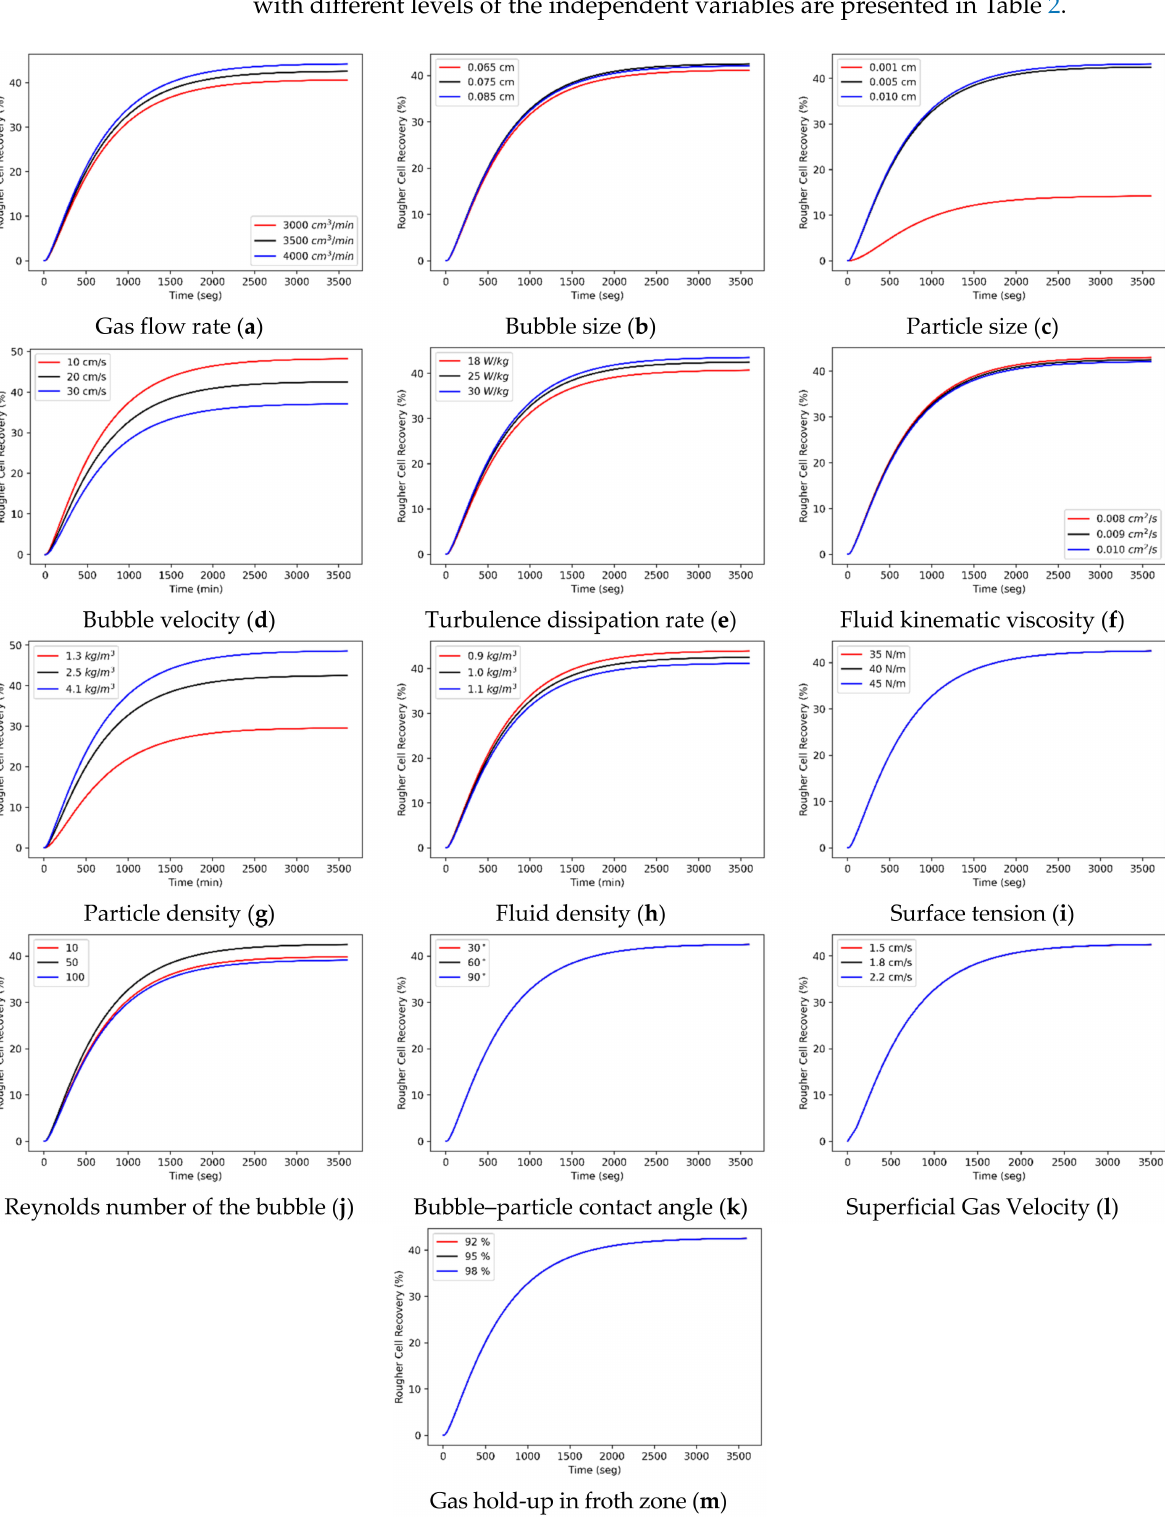
Figure 4. Sensitivity analysis of mineral recovery in the rougher cell based on time and the following variables: gas flow rate ( a ), bubble diameter ( b ), particle diameter ( c ), bubble velocity ( d ), turbulence dissipation rate ( e ), fluid kinematic viscosity ( f ), particle density ( g ), fluid density ( h ), surface tension ( i ), bubble Reynolds number ( j ), bubble–particle contact angle ( k ), superficial gas velocity, and ( l ) gas hold-up in froth zone ( m